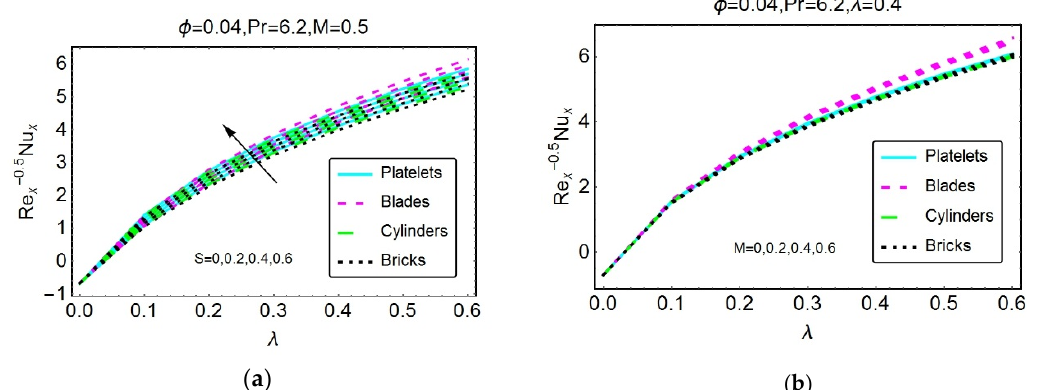
Figure 10. Variations in the Nusselt number for different values of ( a ) S and ( b ) M .